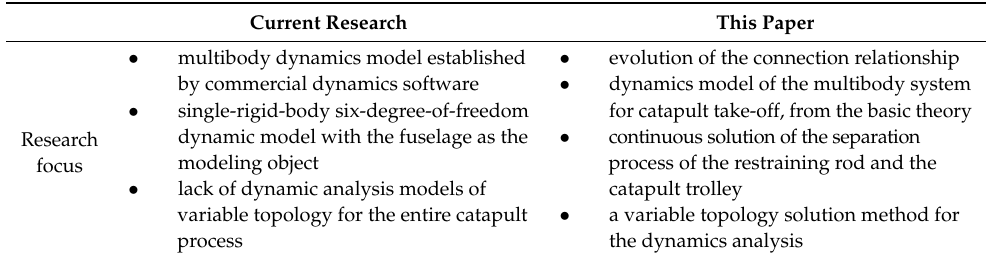
Table 1. Comparison of modeling methods between the published research and this